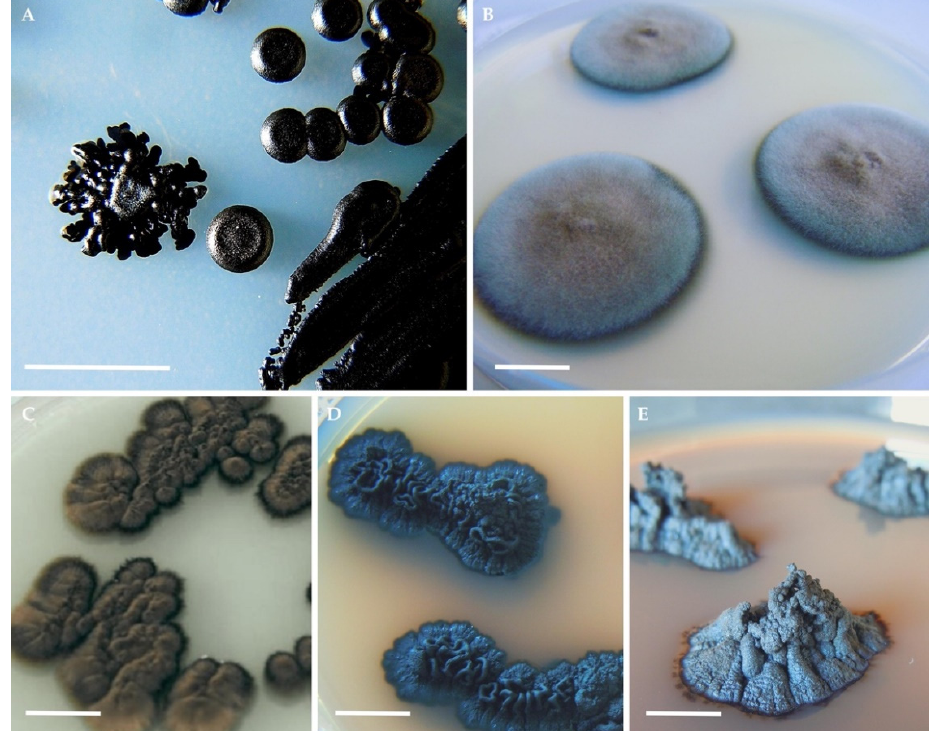
Figure 1. Typical colony morphologies of black yeasts and microcolonial fungi on agar plates. Hortaea werneckii ( A ); Cladophialophora immunda ( B ); Exophiala dermatitidis ( C ); Knufia chersonesos ( D ); Cryomyces antarcticus ( E ). Photos ( A , E ) by Christian Voitl; ( B ) by Barbara Blasi; ( C , D ) by Donatella Tesei. Scale bars: 1 cm.